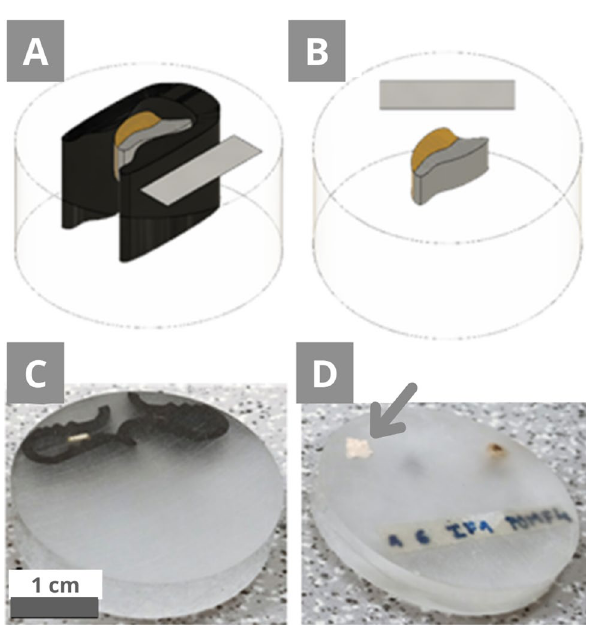
Figure 2. Reference preparation with the fixing clips as (A) a scheme and (C) in reality, and without the clips (B) as a scheme and (D) in reality. The grey arrow shows a part of a sample that floated to the surface of the resin (for detail see Fig. 6). The cross-section diameter is 3